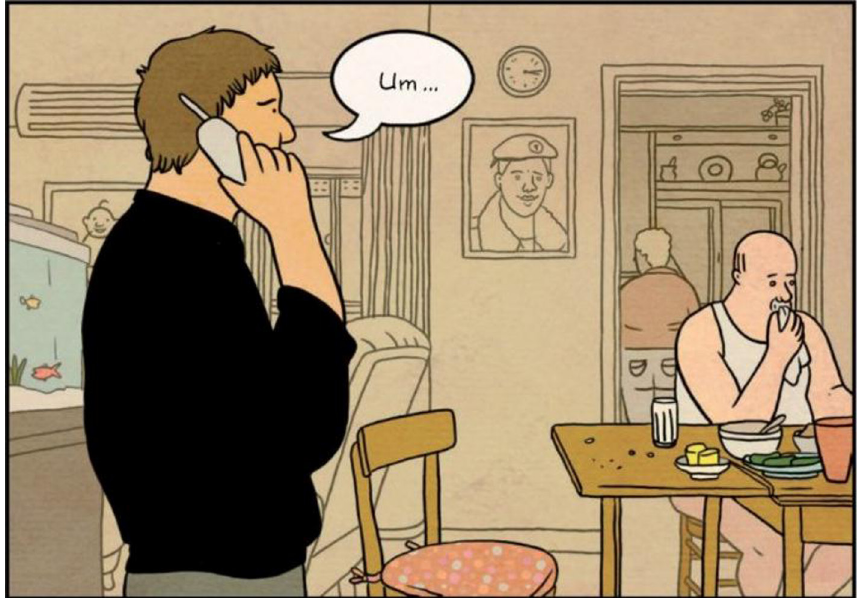
Figure 4: A Drastic Slowdown of Language in Exit Wounds by Rutu Modan, 2007: 67. © 2007 Drawn & Quarterly – Rutu